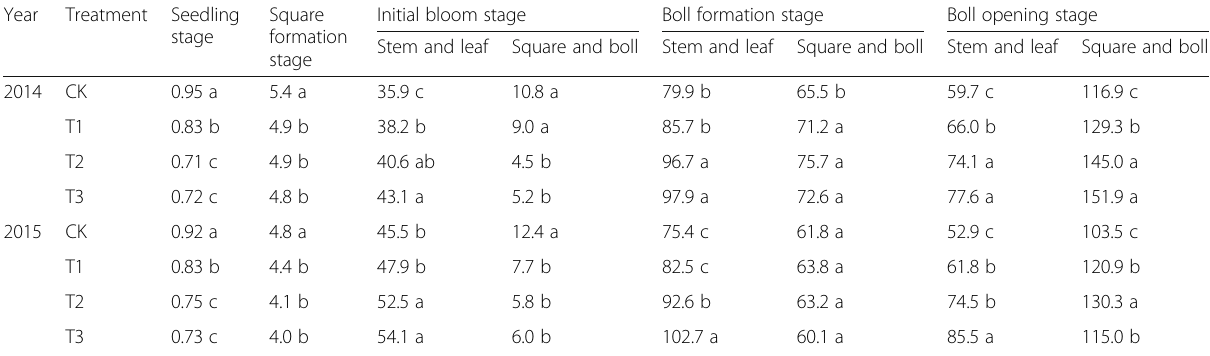
Table 3 Dry matter accumulation of above-ground cotton at different growth stages in different treatments (g·plant − 1 ) Year Treatment Seedling Square Initial bloom stage Boll formation stage Boll opening stage stage formation Stem and leaf Square and boll Stem and leaf Square and boll Stem and leaf Square and stage